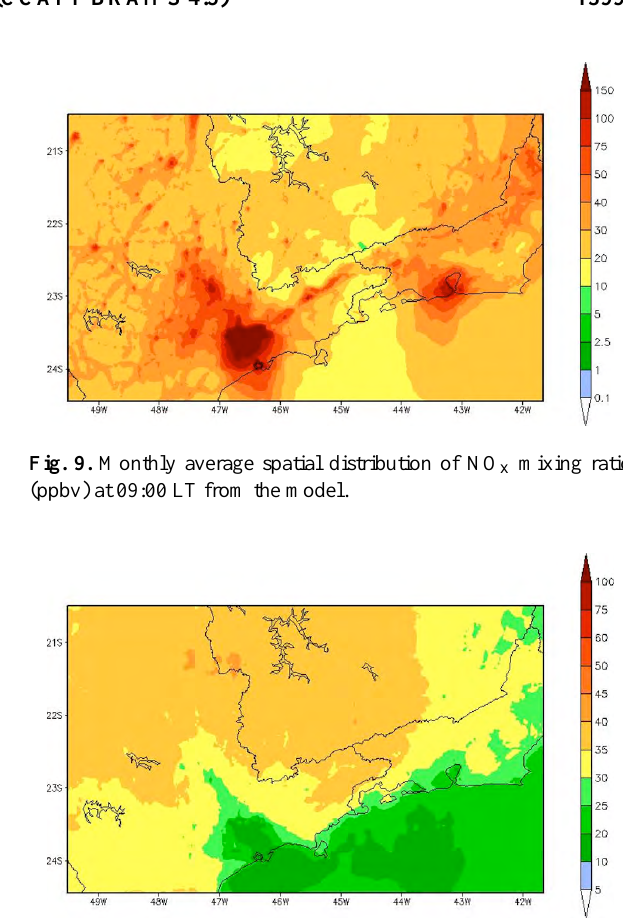
Fig. 10. Monthly average spatial distribution of O 3 mixing ratio (ppbv) at 15:00 LT from the model.